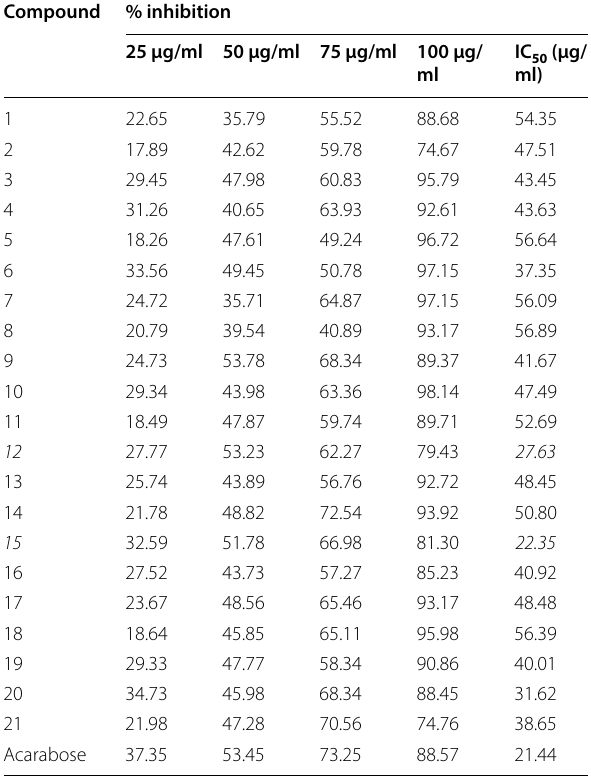
Compound numbers and their significant values are given in italic